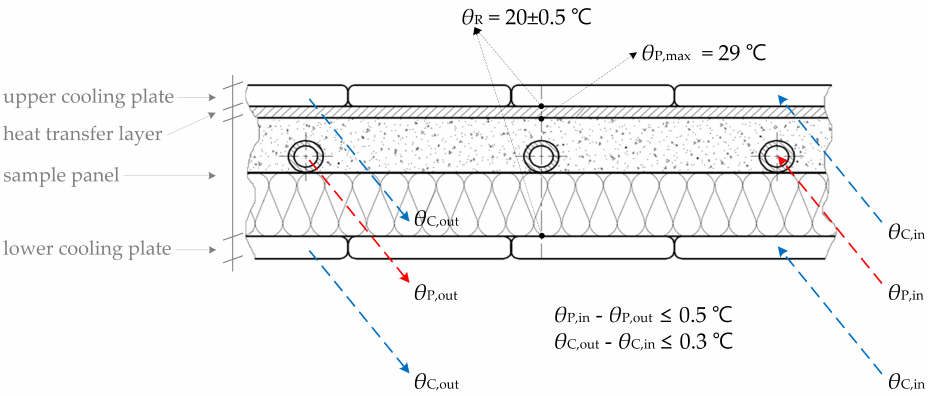
Figure 3. Configuration with target condition based on the EN 1264